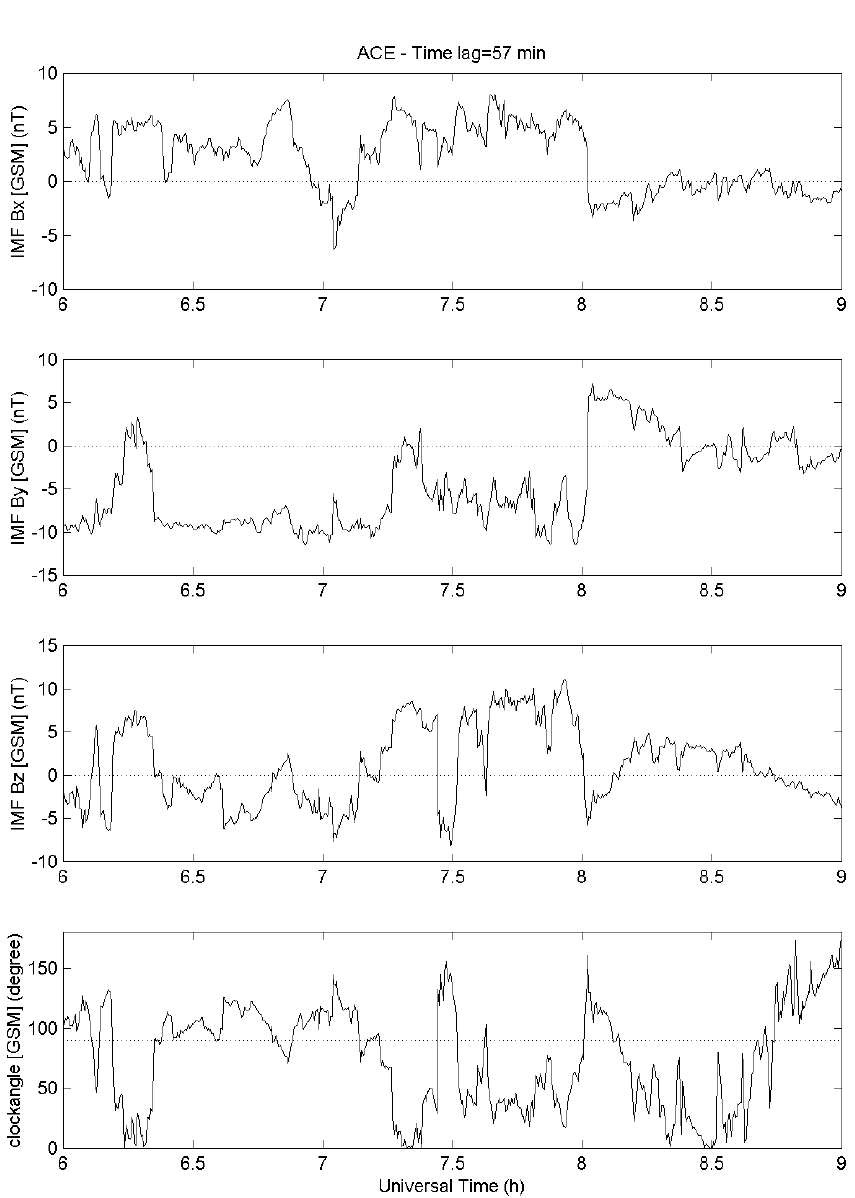
Fig. 1. Interplanetary Magnetic Field in GSM coordinates measured by ACE. Data lagged by 57min. From top to bottom, X -, Y -, Z - component and clock